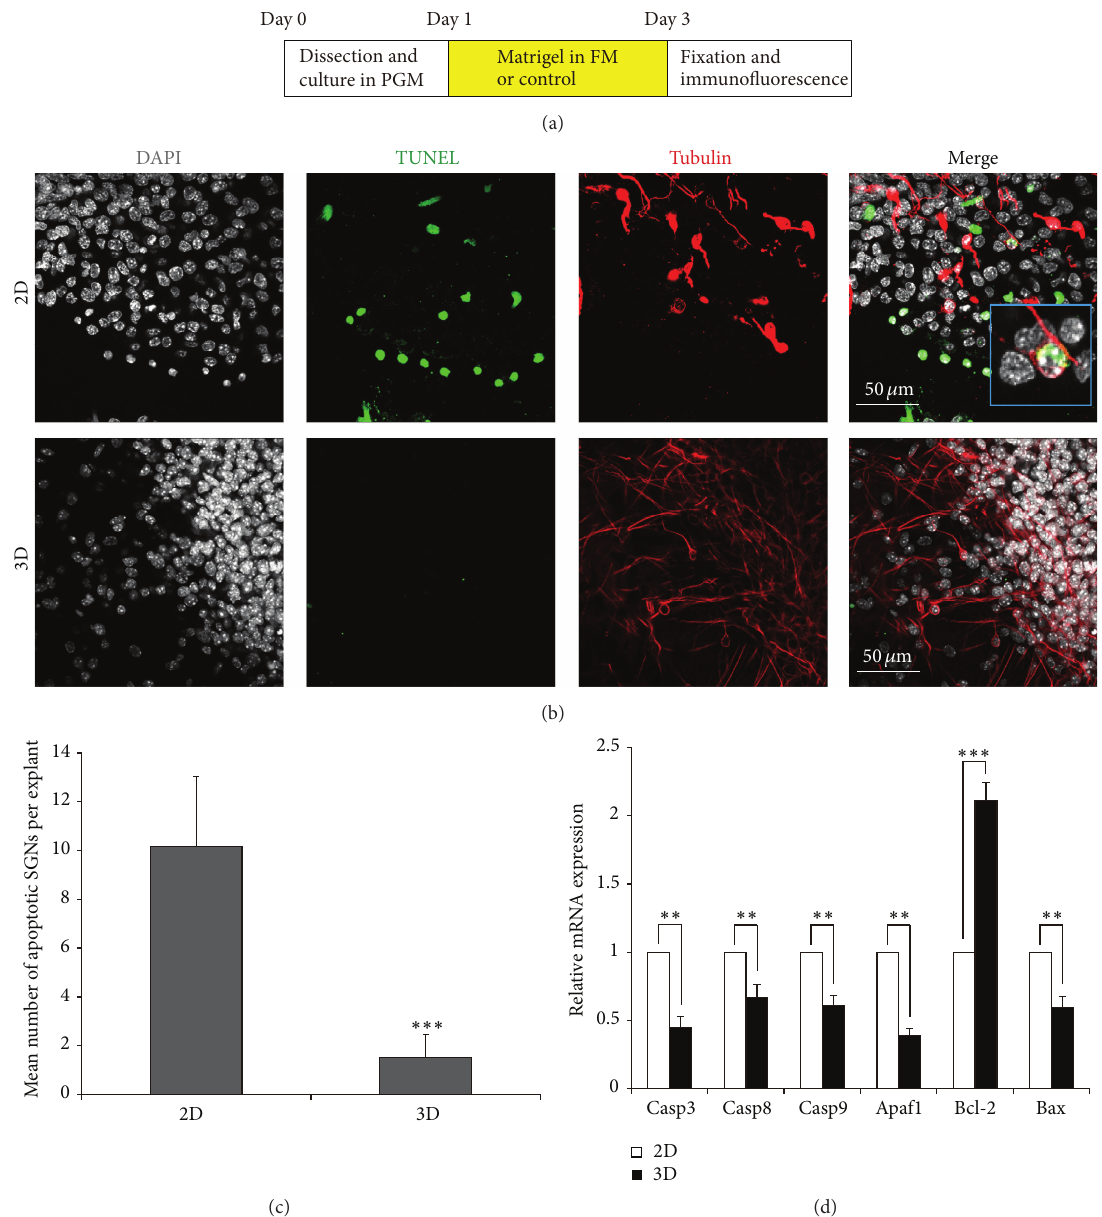
Figure3:3DcultureprotectedSGNexplantsfromapoptosis.(a)Thediagramoftheassay.(b)ApoptoticSGNs(whitearrow)wereobservedin 2D culture, characterized by DAPI (grey), TUNEL (green), and 𝛽 -tubulin (red) costained. (c) Compared with 2D culture, 3D culture reduced the average number of apoptotic SGNs. ∗∗∗ 𝑝 < 0.001 . (d) 3D culture regulated the mRNA expressions of apoptotic genes. ∗∗ 𝑝 < 0.01 and ∗∗∗ 𝑝 < 0.001